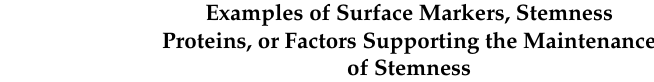
Table 1. Examples of surface markers, stemness proteins, or factors that support the maintenance of stemness across multiple cancer